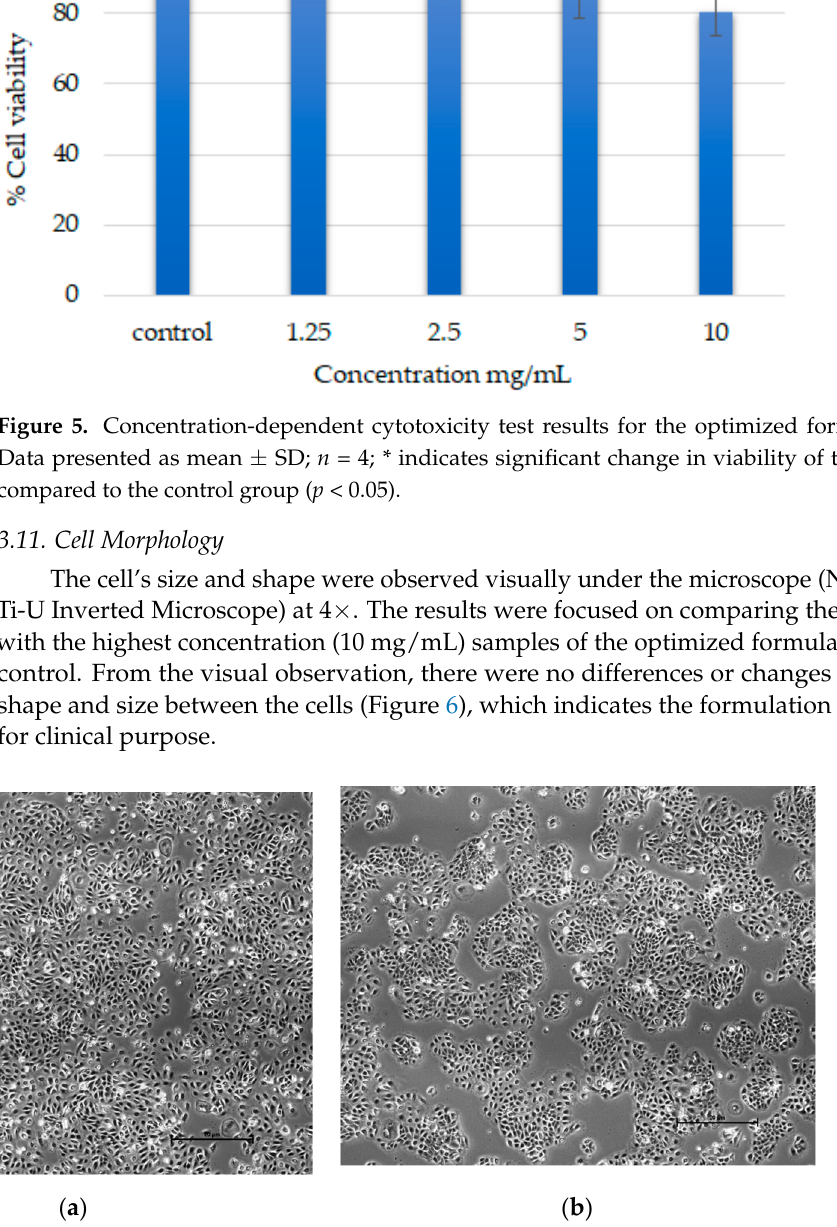
Figure 4. Antimicrobial test results by disc diffusion method (( A ) controlled; ( B ) optimized formulation F3 without drug; ( C ) marketed clindamycin topical solution (1% w / v ); ( D ) standard clindamycin solution (1% w / v ); ( E ) formulation F3 with clindamycin (1% w / v )).